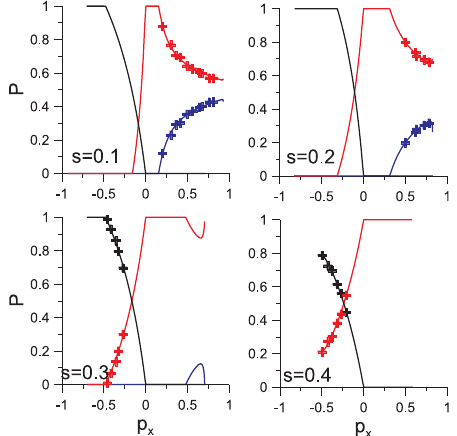
Fig. 10. Analytical profiles of probabilities as functions of p x along the uncertainty curve. Crosses show numerical results. Black colour is used for P , red for P l , and blue for P r